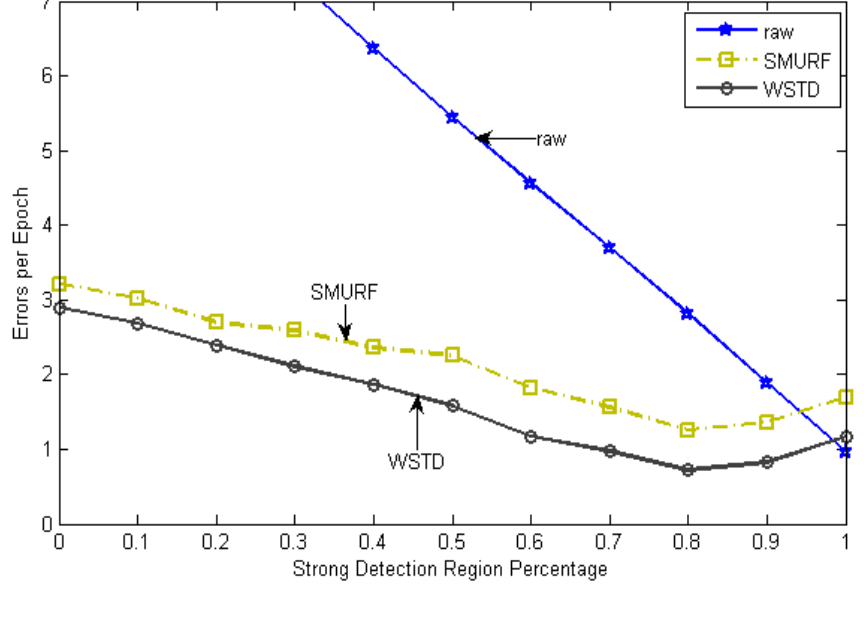
Figure 6. Average errors per epoch as strong-in-field region percentage is